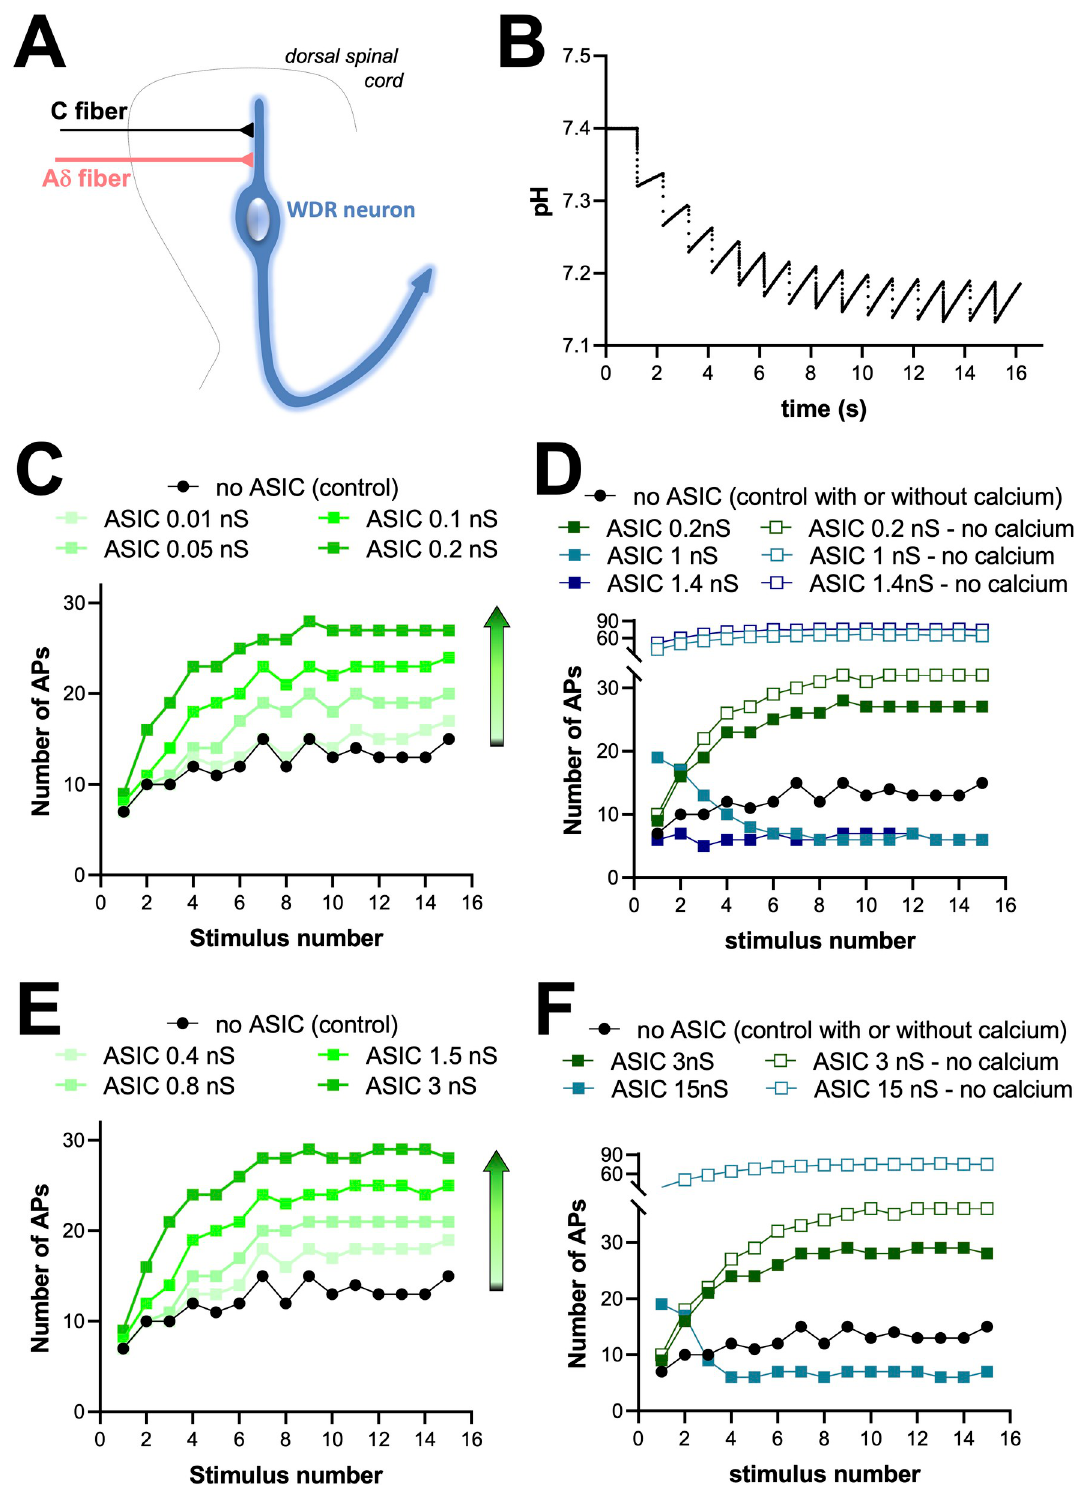
Fig 4. Computational model of WDR neuron with ASIC1a channel parameters and a synaptic cleft acidification system. A , Schematic representation of the computational model used, with a WDR projection neuron receiving directly a 20-synapse connection from both A δ -fibers and C-fibers. B , Simulation curve showing the evolution of synaptic pH as a function of time during windup-inducing stimulations. C , Simulation windup curves obtained without (control, no ASIC, black dots) and with moderate